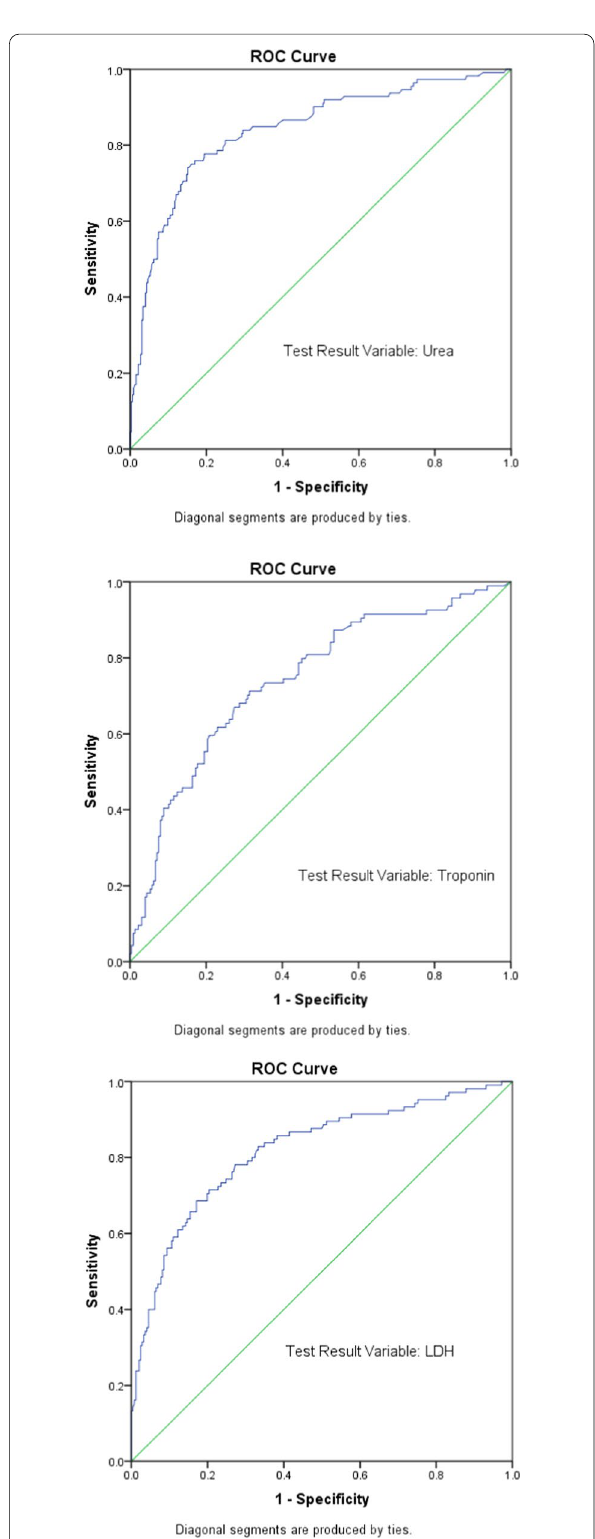
Fig. 2 ROC curves used to suggest possible laboratory predictors for COVID 19